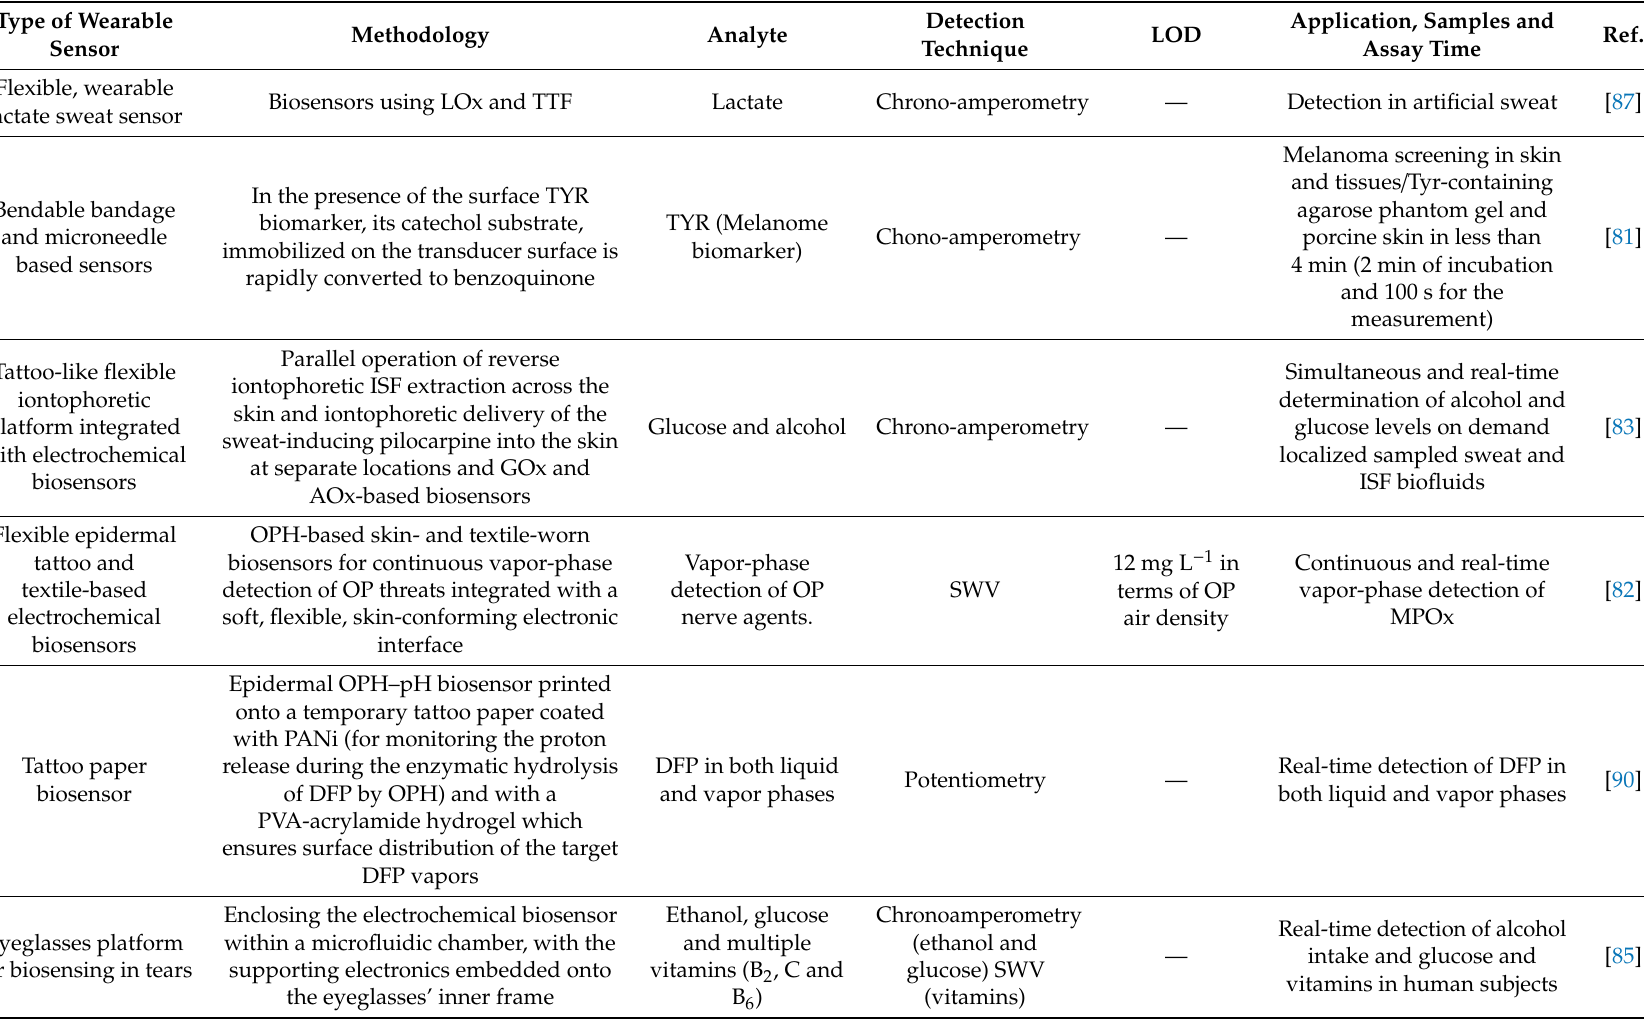
Table 3. Wearable and flexible printed electrodes reported during 2018–2020 for biosensing